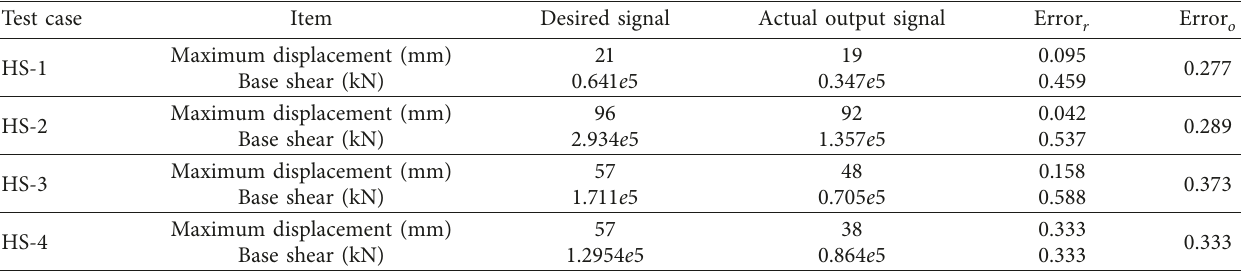
Figure 26: Moment rotation curves of a plastic hinge at the bottom of the roof. Case using (a) the desired signal as the excitation signal and (b) the actual output signal as the excitation signal. Table 5: Structural response error of HS under the desired signal and actual output signal excitations.